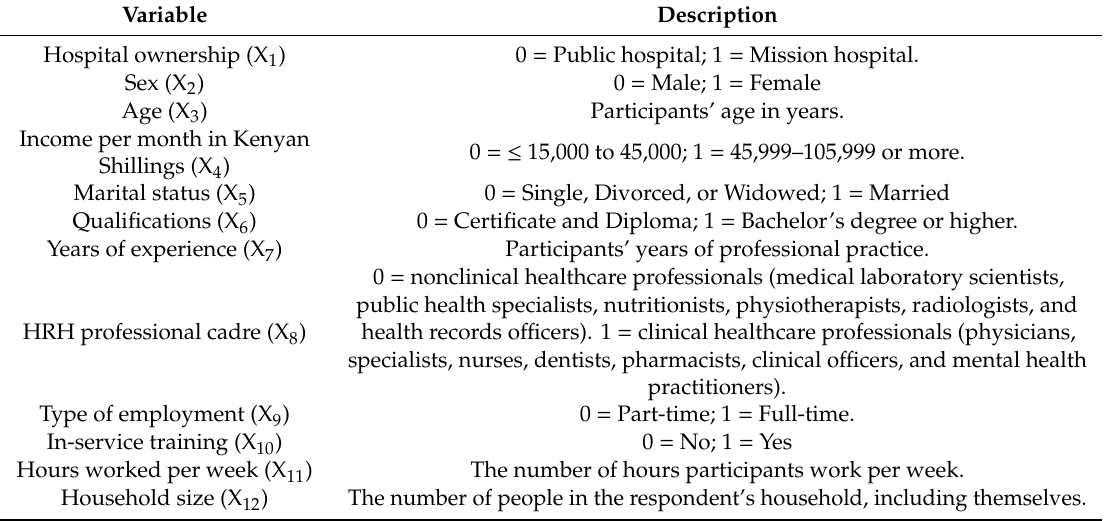
Table 1. Descriptions of sociodemographic and work environment